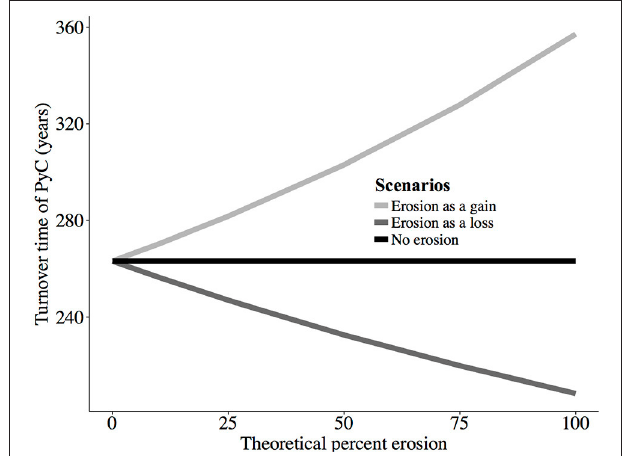
FIGURE 6 | The magnitude of difference in turnover time of PyC associated with discounting erosion as either an input (deposition of material) or loss (erosion of material) term can lead to an ∼ 150-year difference error in turnover time depending on the fractional amount of erosion occurring. The theoretical percent erosion is the percent of an erosion rate (K e , from Equation 1) that is accounted for within this model from an assumed rate of erosion of 0.001 (1,000-year turnover time of PyC via erosion, a slow erosion rate). This erosion rate is added (deposition of material) or subtracted (erosion of material) from a base decomposition rate (k 0 , from Equation 1) of 0.004, corresponding to a 250-year turnover time (Hammes et al., 2008). A theoretical percent erosion of 0% corresponds to no erosion contribution of input or output of PyC from a soil; whereas a theoretical percent erosion of 100% would lead to either an input (gain) of PyC into the soil or loss of PyC from the soil that would increase or decrease the turnover time of PyC by ∼ 70 years